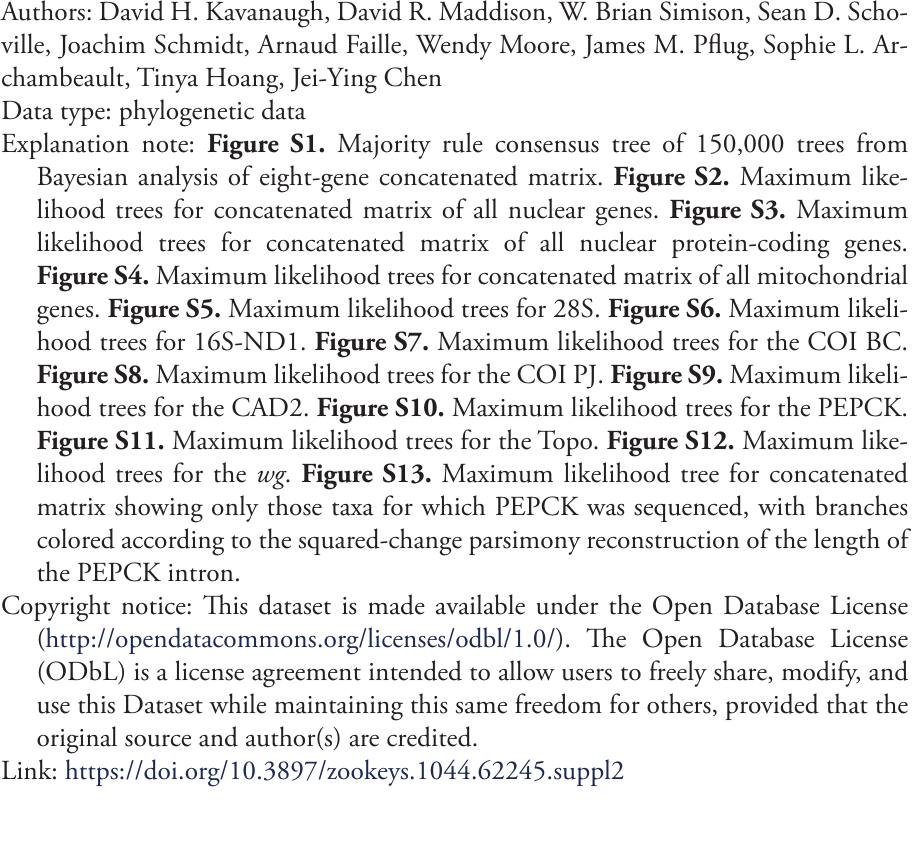
Bayesian analysis of eight-gene concatenated matrix. Figure S2. Maximum like- lihood trees for concatenated matrix of all nuclear genes. Figure S3. Maximum likelihood trees for concatenated matrix of all nuclear protein-coding genes. Figure S4. Maximum likelihood trees for concatenated matrix of all mitochondrial genes. Figure S5. Maximum likelihood trees for 28S. Figure S6. Maximum likeli- hood trees for 16S-ND1. Figure S7. Maximum likelihood trees for the COI BC. Figure S8. Maximum likelihood trees for the COI PJ. Figure S9. Maximum likeli- hood trees for the CAD2. Figure S10. Maximum likelihood trees for the PEPCK. Figure S11. Maximum likelihood trees for the Topo. Figure S12. Maximum like- lihood trees for the wg . Figure S13. Maximum likelihood tree for concatenated matrix showing only those taxa for which PEPCK was sequenced, with branches colored according to the squared-change parsimony reconstruction of the length of the PEPCK